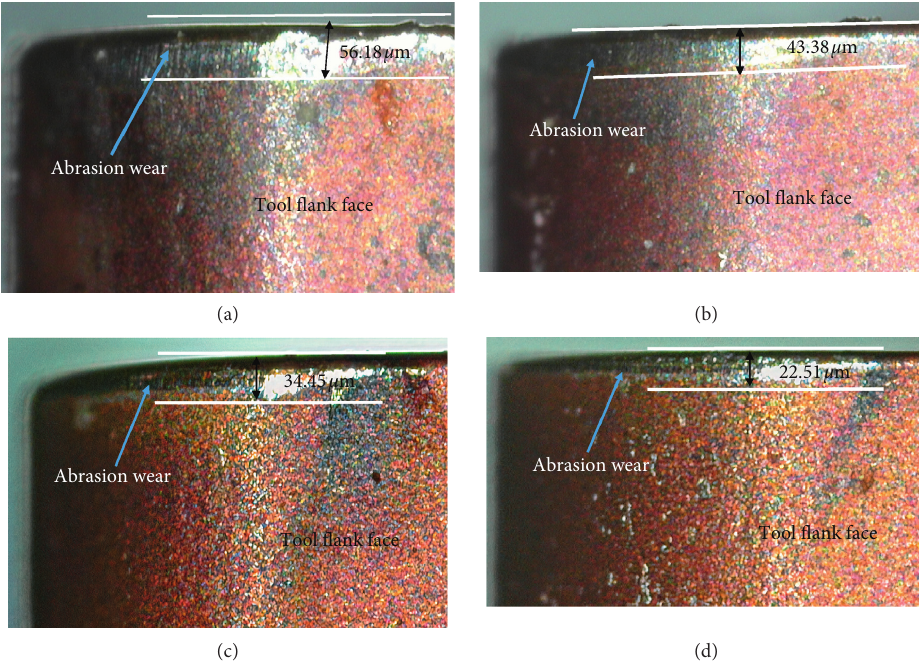
Figure 6: Tool flank wear (after 150mm) for (a) Dry, (b) CCAVT, (c) MQCL, and (d) Hybrid NF-MQCL machining environments at Vc: 200m/min and f: